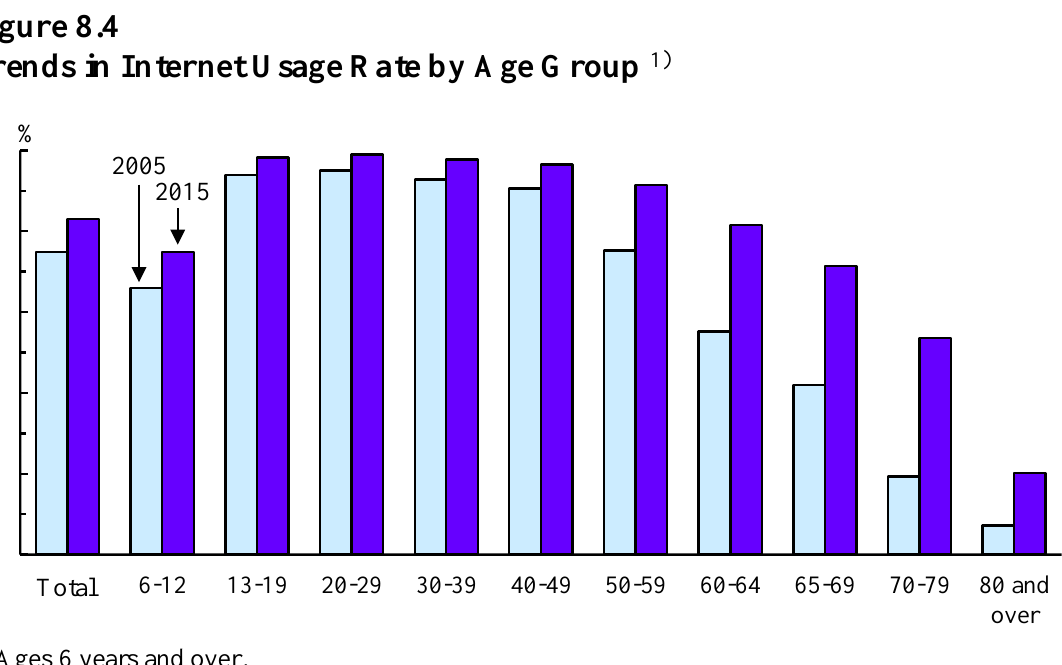
Communications.Total 1) Ages 6 years and over. Source: Ministry of Internal Affairs and